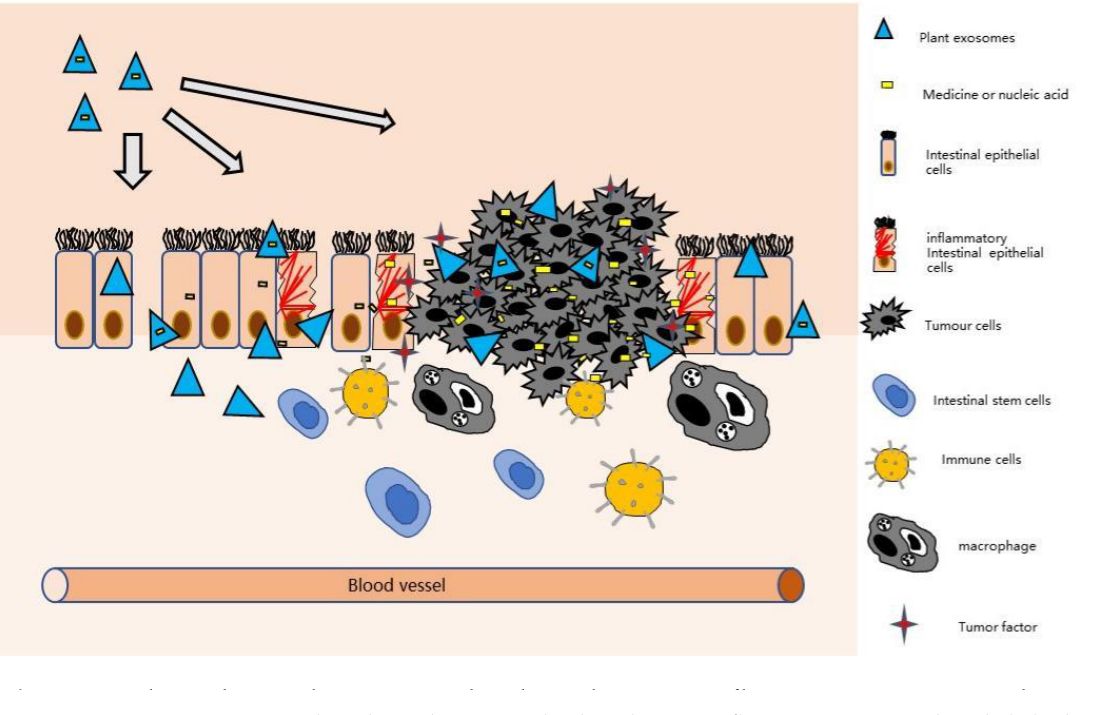
Figure 4. Plant-derived exosomes loading drugs to inflammatory intestinal epithelial. The exosomes secreted by plants can load chemical drugs or nucleic acid drugs to effectively treat CAC and reduce the size of tumors. At the same time, plant-derived exosomes can affect intestinal epithelial cells, macrophages, and other intestinal cells to reduce intestinal inflammation and create a more healthy intestinal microenvironment.